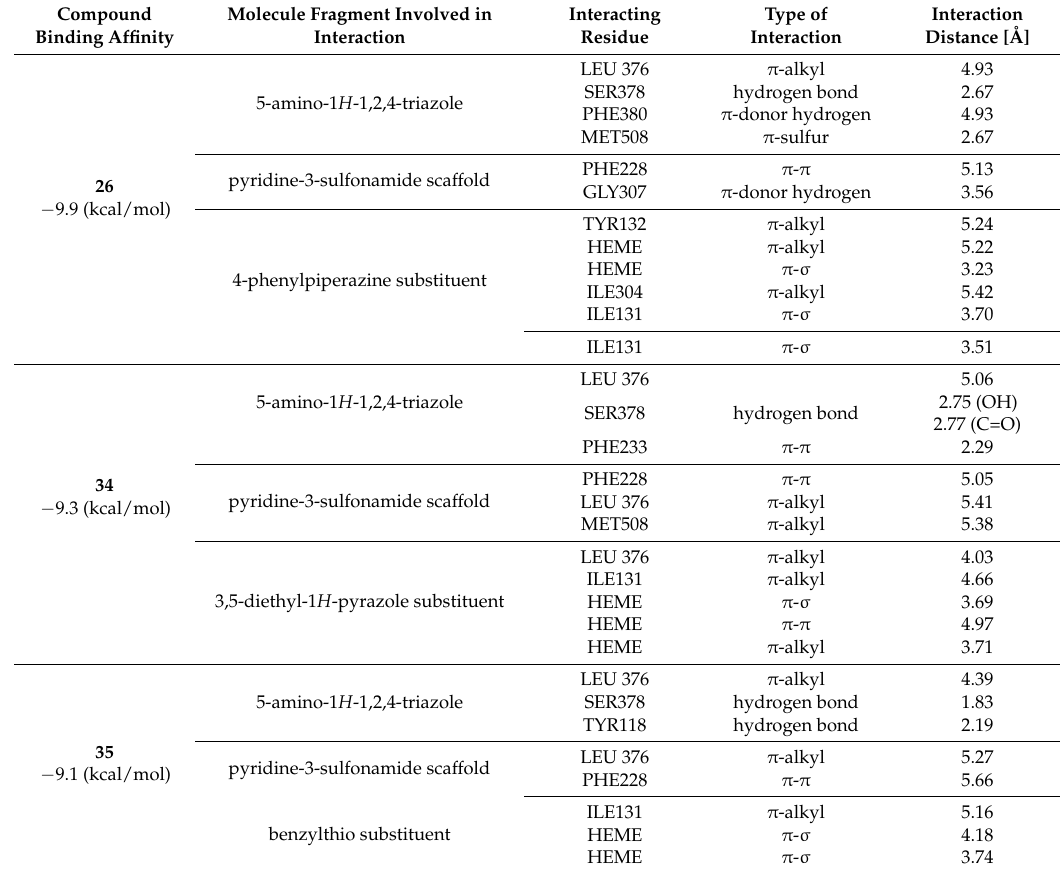
Table 2. Predicted binding affinity and non-covalent interaction between compounds 26 , 3 4 and 35 and the active site of